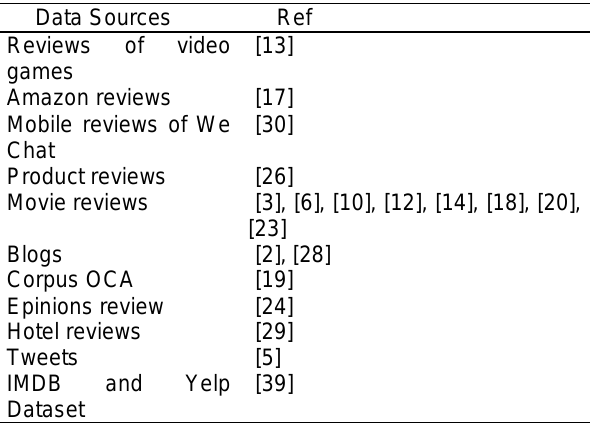
Table 3. Comparative study by data sources